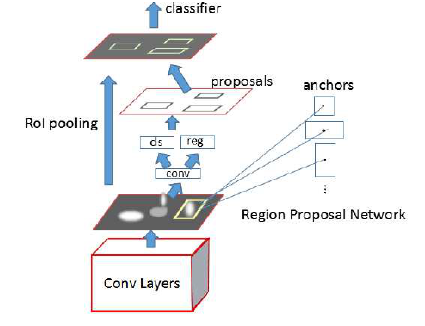
Figure 1. R-CNN Algorithm[6]